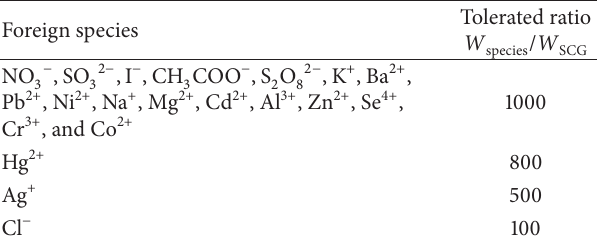
Table 2: Effect of foreign ions on the determination of 12ngmL − 1 SCG.